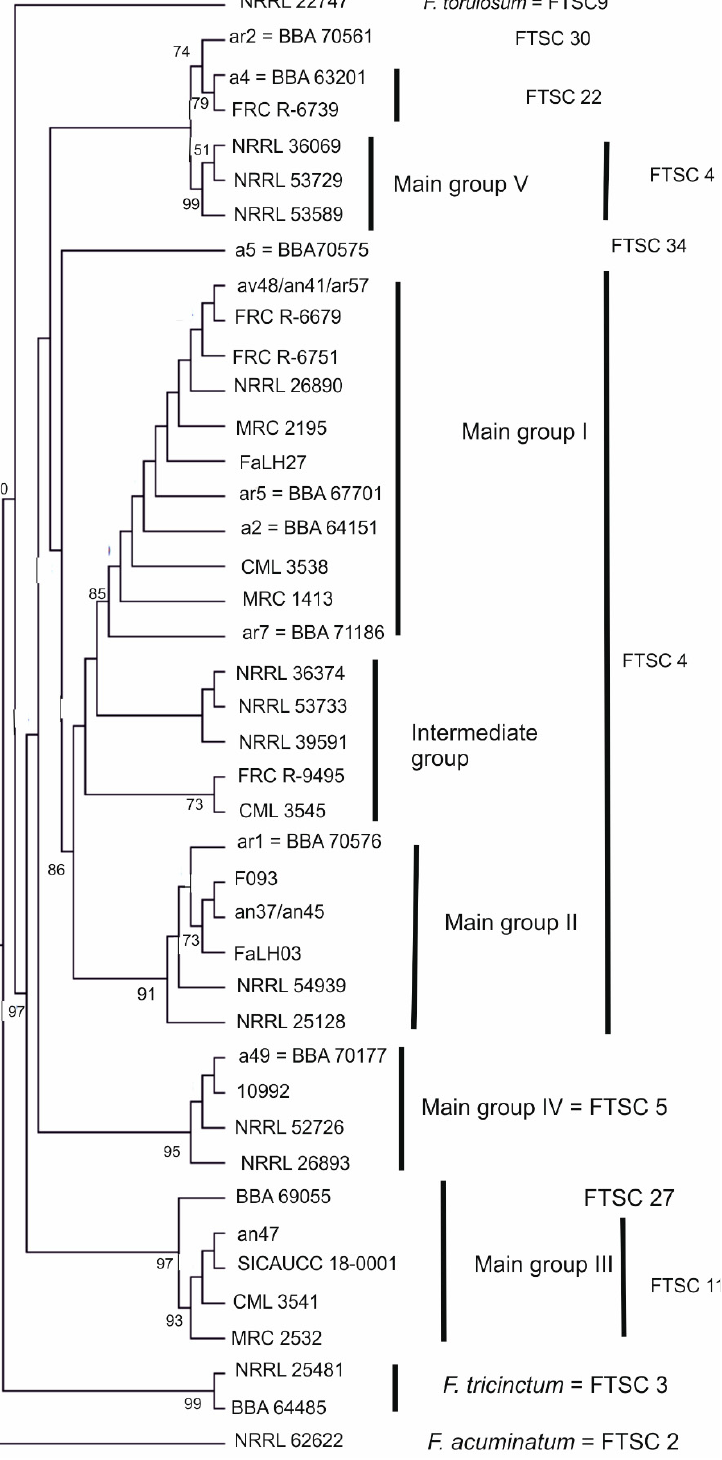
Figure 4. Maximum-parsimony consensus tree of translation elongation factor 1-alpha ( TEF1 ) se- quences, including strains from the work of Laraba et al. [11] (2022). Bootstrap values are indicated above nodes based on 500 pseudoreplicates of the data. Only branches present in more than 50% of the trees are shown. F. tricinctum and F. acuminatum strains are